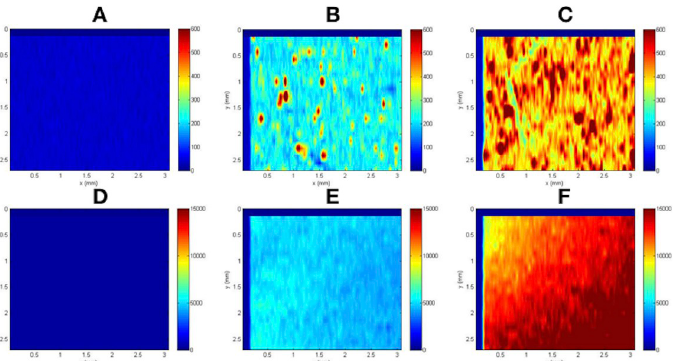
Fig 3. Elemental mapping of inorganic nanoparticles in the hydrogel. (A and D: mPA, B: H5/mPA, C: H10/mPA, E: M5/mPA, F: M10/mPA) Color bar on the right side indicates element intensity, with blue and red corresponding to low and high concentration